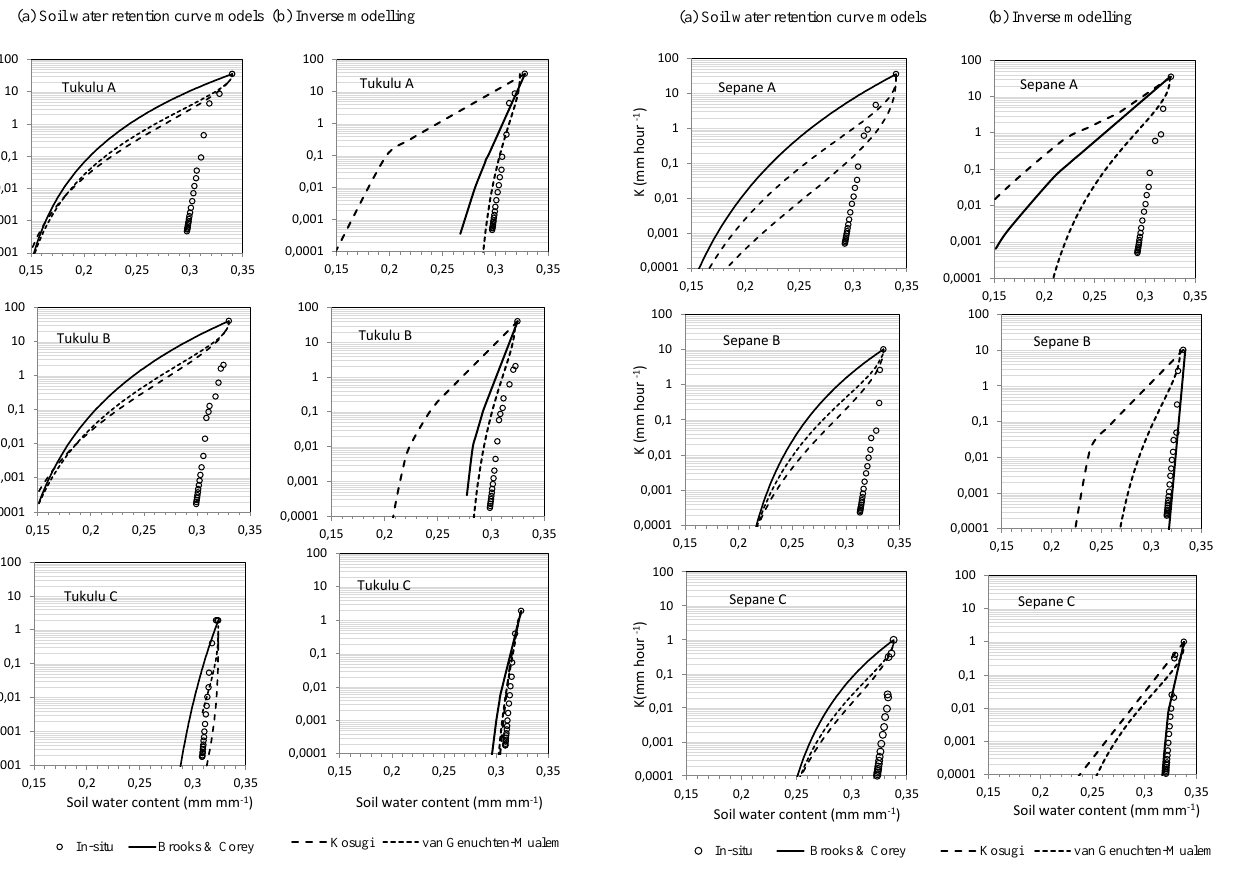
Fig. 6. Models predictions of in situ hydraulic conductivity based on Figure 6 Models predictions of in-situ hydraulic conductivity based on the soil water the retention curve and inverse modelling for the Sepane diagnostic retention curve (a) and inverse modelling (b) for the Sepane diagnostic horizons.